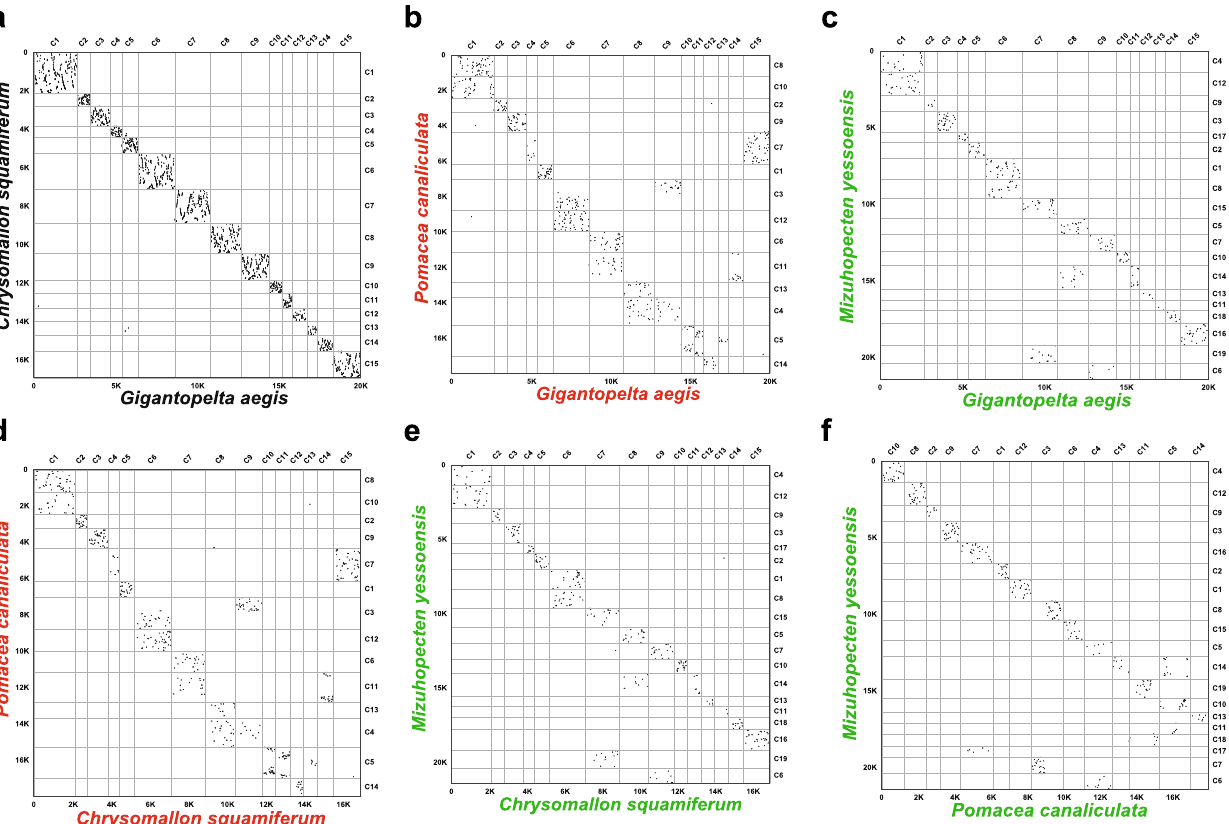
Fig. 4 Chromosome-scale synteny among four Mollusca genomes. Chromosome-scale synteny is shown in dot plots with comparisons among the genomes of Gigantopelta aegis (15 chromosomes), Chrysomallon squamiferum (15 chromosomes), Pomacea canaliculata (14 chromosomes), and Mizuhopecten yessoensis (19 chromosomes). These plots include the comparison a between G. aegis and C. squamiferum (comparison within Neomphalida: black), b between G. aegis and P. canaliculata (comparison within Gastropoda: red), c between G. aegis and M. yessoensis (comparison within Mollusca: green); d between C. squamiferum and P. canaliculata (comparison within Gastropoda: red), e between C. squamiferum and M. yessoensis (comparison within Mollusca: green), and f between P. canaliculata and M. yessoensis (comparison within Mollusca: green). Each dot represents a synteny block. The numbers on the left and the bottom are the accumulation of the genes in the chromosomes. The colour scheme follows the taxon indicator colours in Fig. 3. C: chromosome. Source data of a – f are provided as a Source Data fi